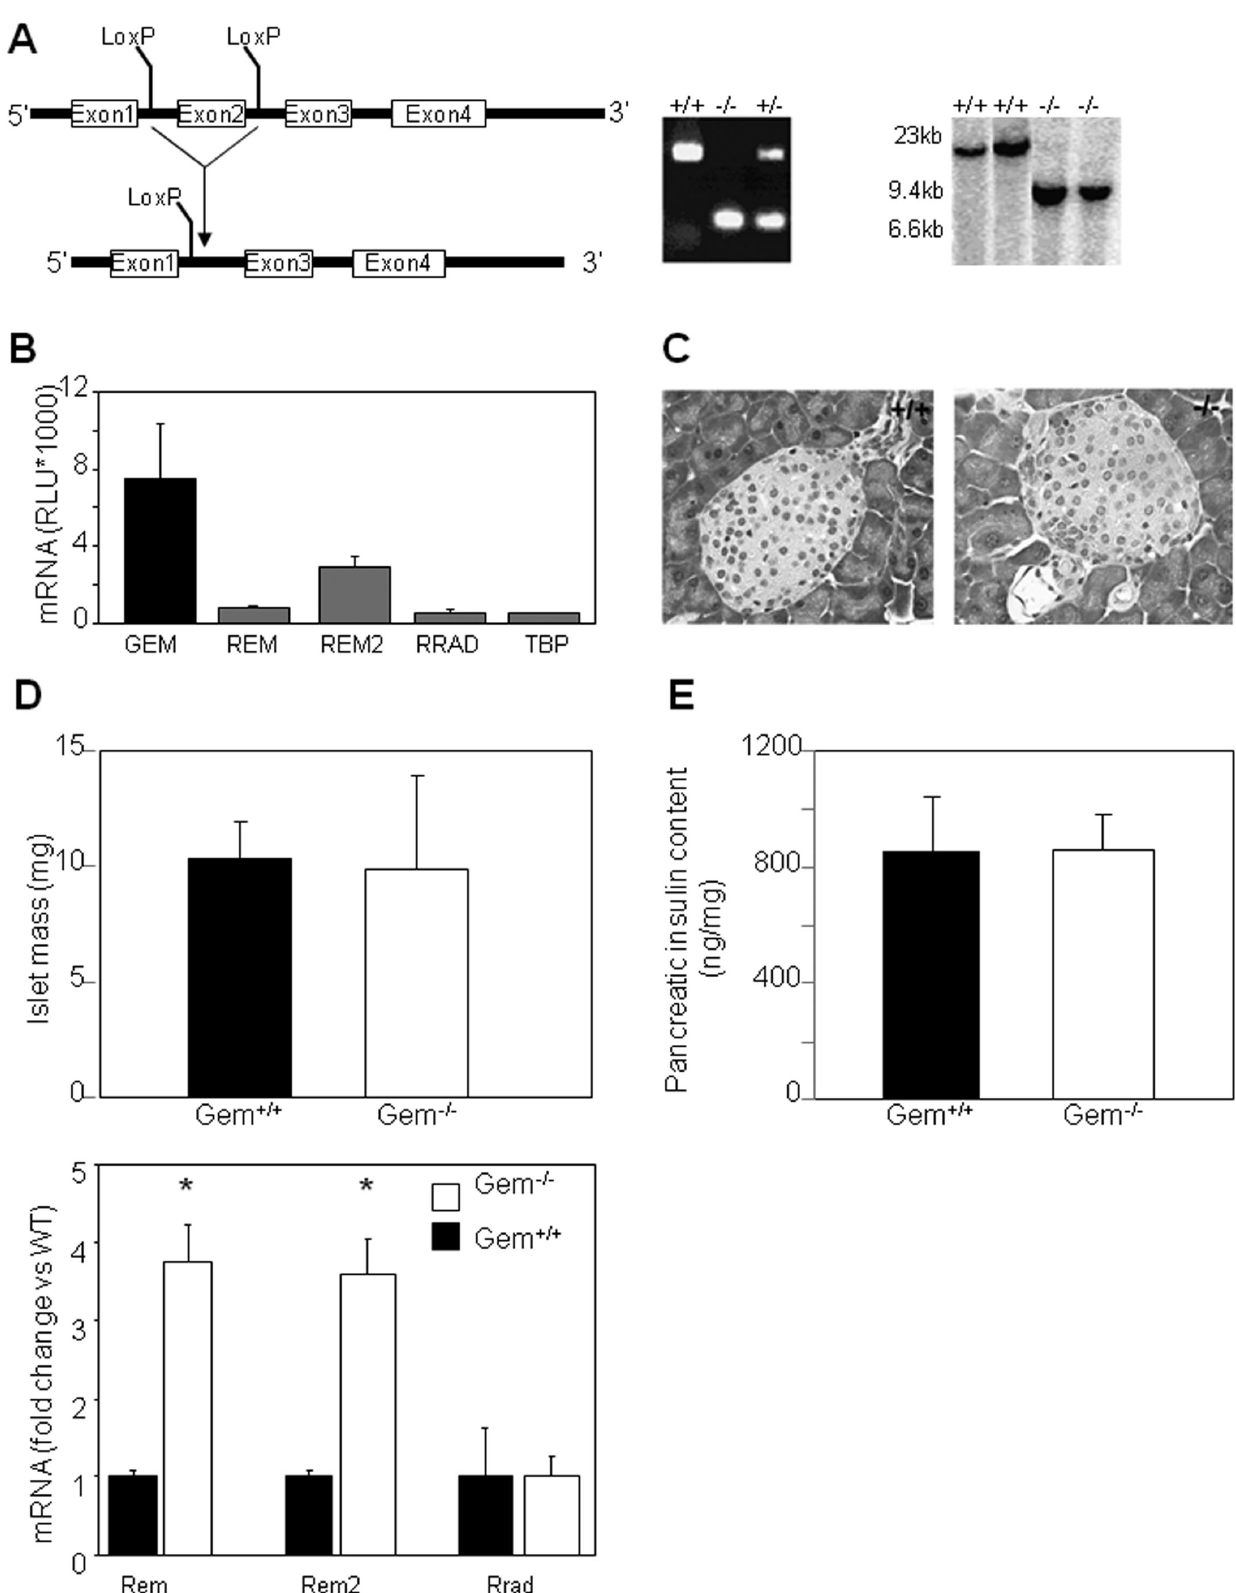
Figure 1. Gem deletion does not alter islet development . A ) Lox-p sites were introduced on either side of exon 2 of the Gem gene. Deletion of exon 2 was confirmed by PCR and by Southern blotting. B ) GEM mRNA is highly expressed in human islets compared to other members of the RGK family and to the house-keeping gene TATA-box binding protein (TBP). C ) Islet morphology and islet mass ( D ) were not altered by Gem deletion in